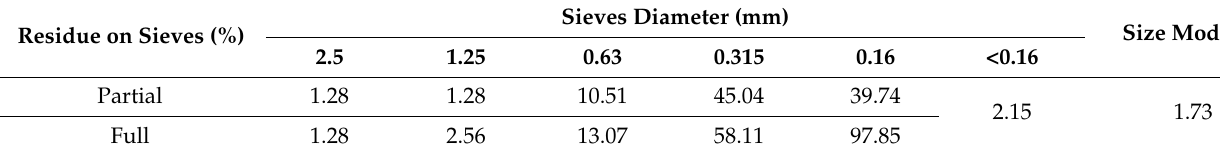
Table 2. Grain composition and modulus of sand size.